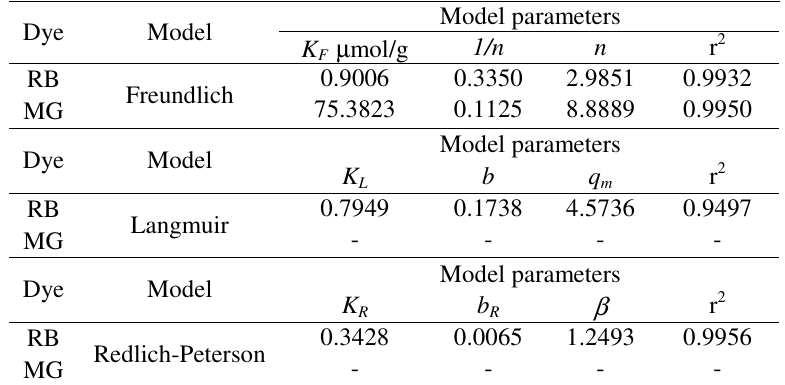
Model parameters